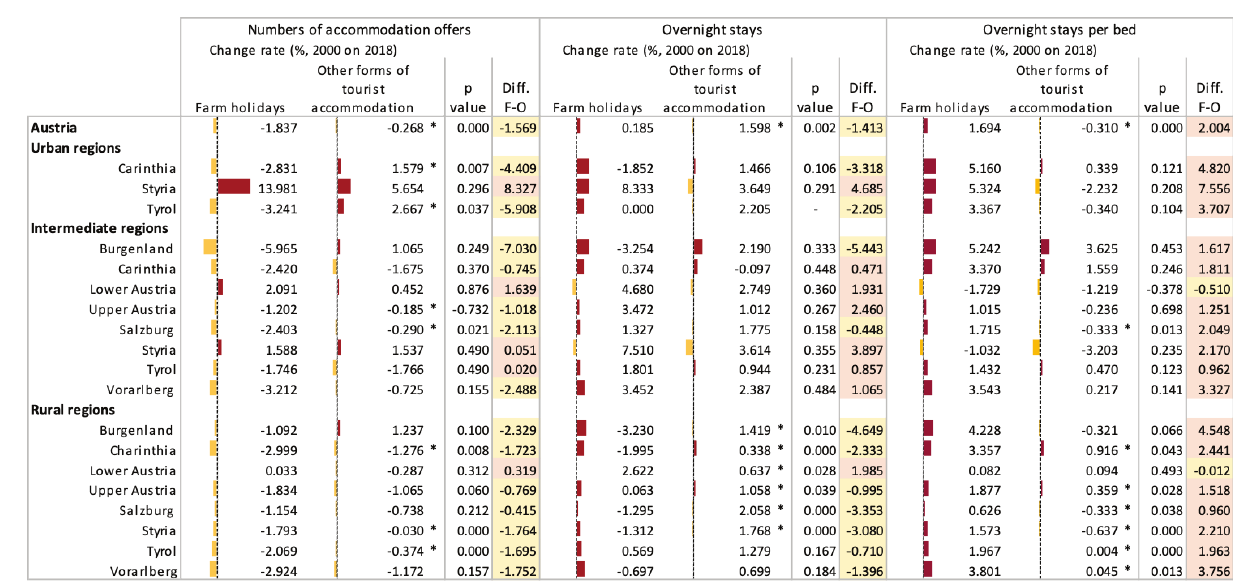
Table 4: Change (%, 2000 on 2018) in the characteristics ‘number of accommodation offers’ and ‘overnight stay per bed’ for farm holidays and ‘other forms of tourist accommodation’ by NUTS3 regions (Statistics Austria